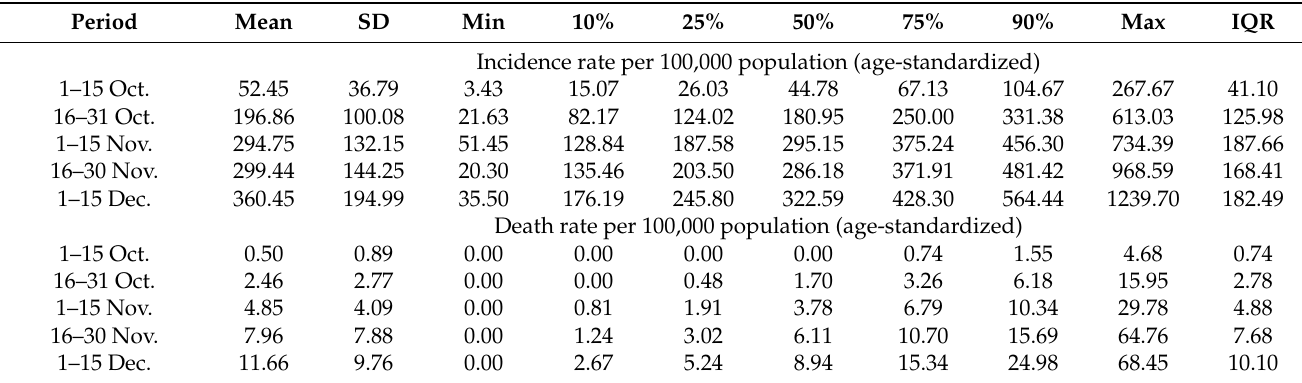
Table 1. Distribution of age-standardized COVID-19 incidence and death rates per 100,000 person-years by period ( n = 401 counties, IQR interquartile